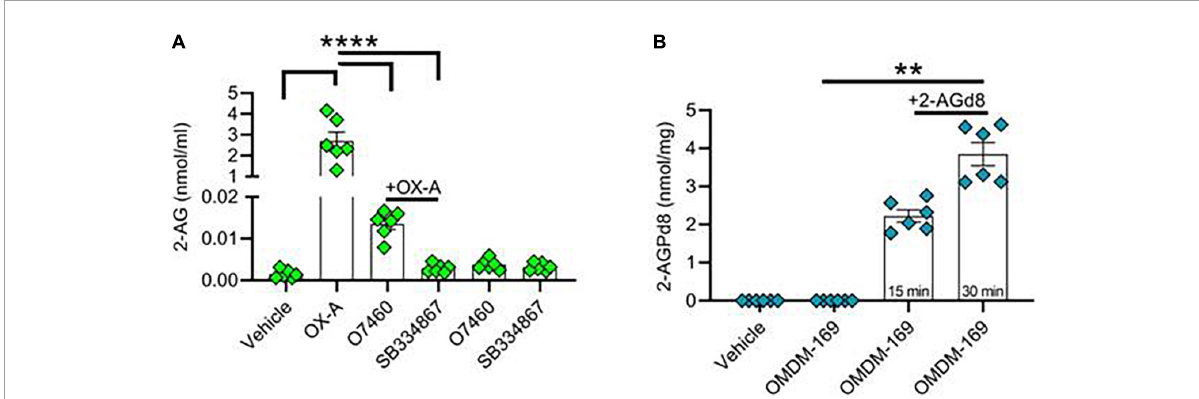
FIGURE2 Orexin-A raises 2-AG and 2-AG-derived 2-AGP levels in hippocampal neurons. (A) Bar graph with mean ± SEM. of 2-AG levels in hippocampal primary neurons in different experimental condition: vehicle, OX-A (300 nM), OX-A (300 nM), + O7460 (10 µ M), OX-A (300 nM), + SB334867 (10 µ M), O7460 (10 µ M), SB334867 (10 µ M). 2-AG levels: vehicle (0.001 ± 0.0004 nmol/ml), OX-A (2.6 ± 0.4 nmol/ml), OX-A + O7460 (0.01 ± 0.001), OX-A + SB334867 (0.002 ± 0.0004 nmol/ml), O7460 (0.003 ± 0.0005 nmol/ml), SB334867 (0.003 ± 0.0003 nmol/ml), n = 6 wells per experimental group, one-way ANOVA with Bonferroni post hoc test, F = 6.3. (B) Bar graph with mean ± SEM. of 2-AGPd8 levels in hippocampal primary neurons in different experimental conditions: Vehicle, OMDM-169 (10 µ M), 2-AGd8 (50 µ M) + OMDM-169 (10 µ M) for 15 and 30 min of incubation. 2-AGPd8 levels: vehicle and OMDM-169 (undetectable), 15 min 2-AGd8 + OMDM-169 (2.22 + 0.15 nmol/mg), 30 min 2-AGd8 + OMDM-169 (3.8 ± 0.3 nmol/mg), Kruskal–Wallis test and Dunn’s post-hoc test, Kruskal–Wallis statistic 22.20, ** p <